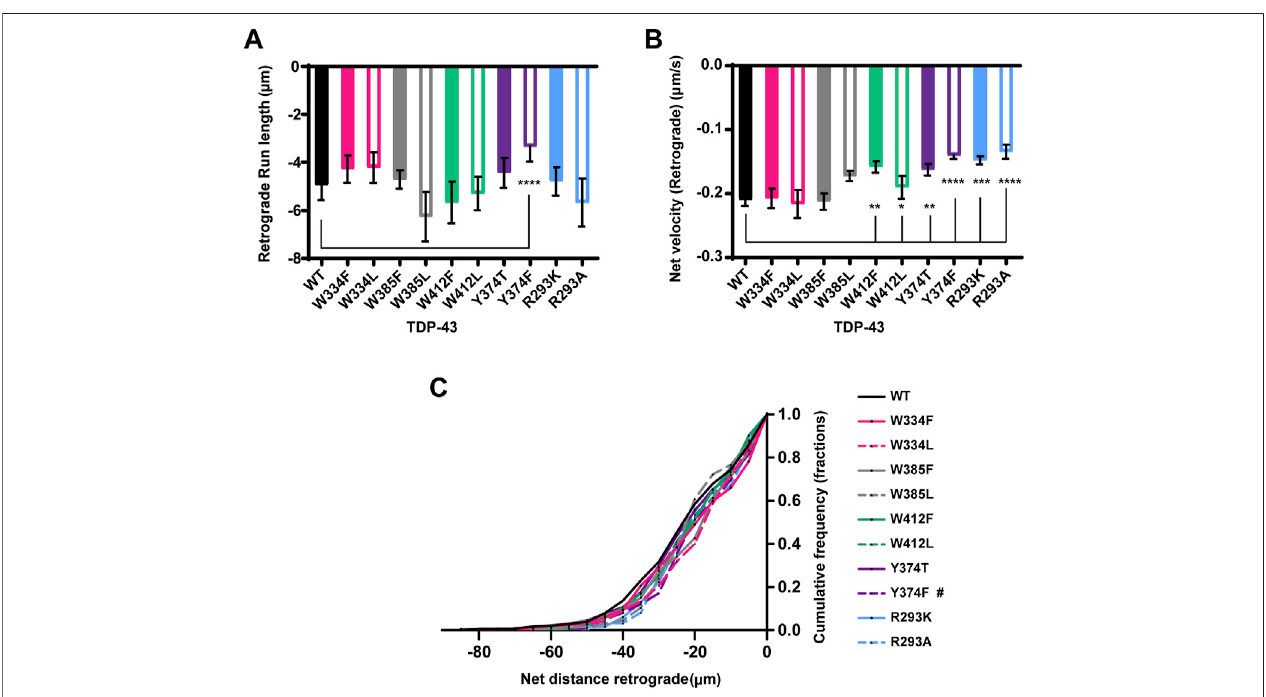
FIGURE 6 | TDP-43 mutations disrupting Y374 in the LCD may affect retrograde motility. (A) The run lengths ( μ m) of motile WT TDP-43 or TDP-43 LCD W/Y/R mutantRNP granules moving in retrograde direction are determined using custom semi-automated analysis in MATLAB and the resulting run lengths are plotted (N = 3, WT n =38andY374F n =89). (B) Theretrogradenetvelocity( μ m/s)foreachofthemotileWTTDP-43orTDP-43LCDW/Y/RmutantRNPgranulewasdeterminedusing MATLAB software and the average net velocity is plotted (N = 3, WT n = 120, W412F n = 86, W412L n = 82, Y374T n = 91, Y374F n = 114, R293K n = 82, and R293A n = 41). Error bars represent standard error mean. (C) Retrograde net distance cumulative frequency distribution of TDP-43 WT and LCD W/Y/R mutant RNP granules,N=3independent experiments. OnewayANOVA (Kruskal – Wallistest withDunn ’ scorrection formultiplecomparisons)wasused todetermine thestatistically signi fi cant difference among different samples. # p < 0.1, * p < 0.05, ** p < 0.01, *** p < 0.0005, and **** p <